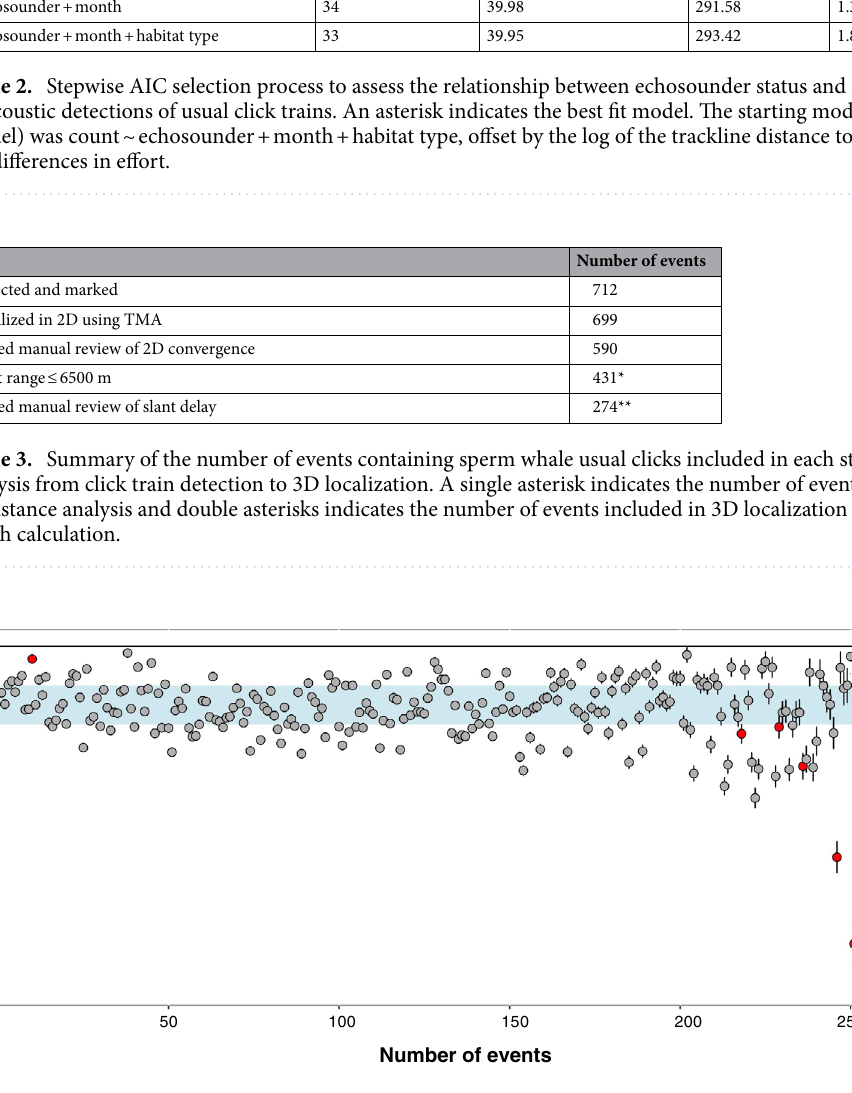
Figure 5. Average dive depth with depth error calculated for 274 events. The events are ordered based on the depth error value. The average depth was rejected for nine events (red points). The interquartile range for the entire dataset is highlighted in blue (first quartile = 411 m, third quartile = 821